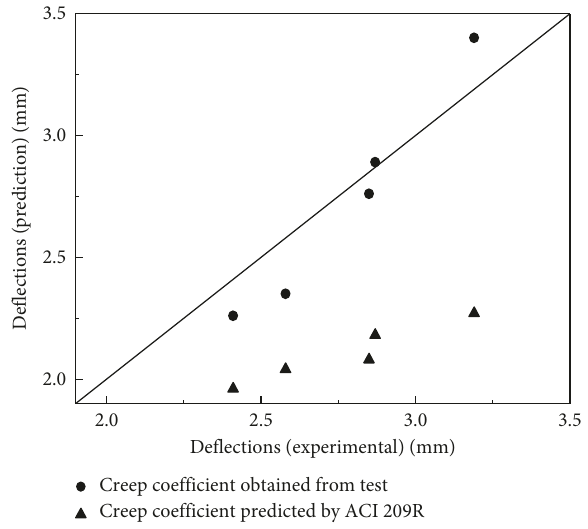
Figure 13: Predicted deflections at 331 days after loading compared with the test